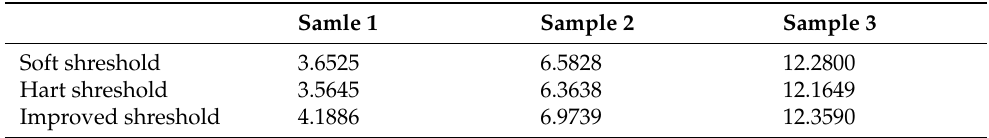
Table 2. Signal-to-noise ratio